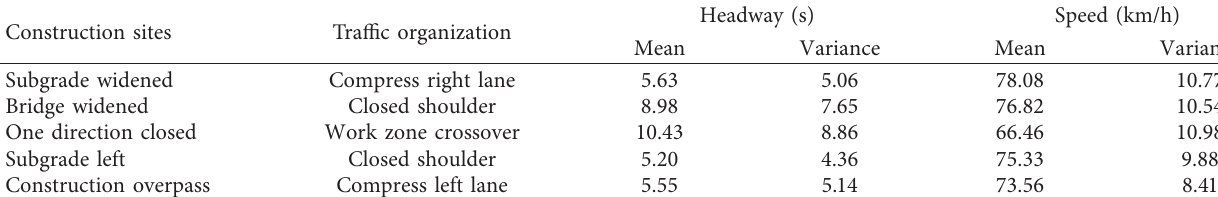
Table 1: Traffic flow data about different construction sites.